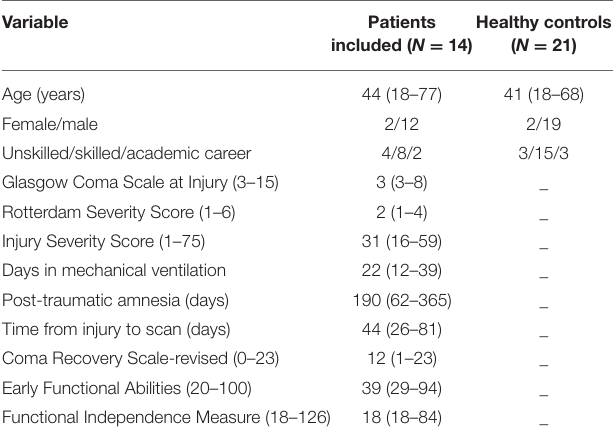
TABLE 2 | Summary of patients’ and healthy controls’ characteristics.